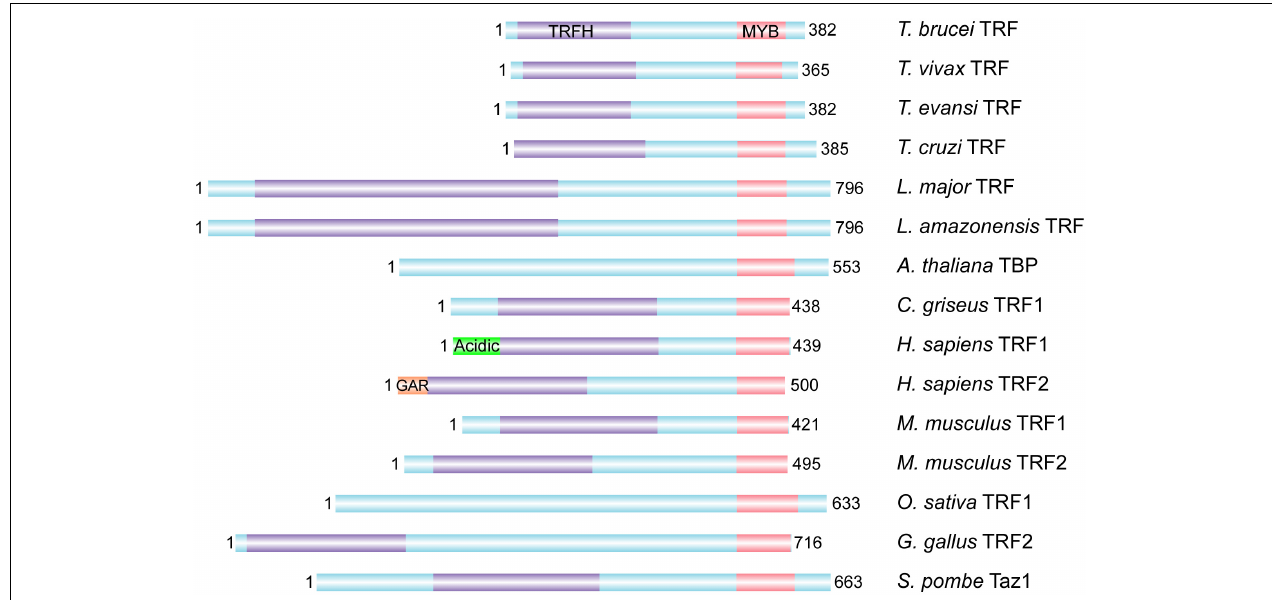
FIGURE 2 | TRF homologs from various organisms. The DNA binding Myb domain, the homodimerization TRFH domain, the N-terminal acidic domain of human TRF1 and basic GAR domain of human TRF2 are marked whenever identified. In addition, Leishmania amazonensis TRF has been identified and shown to associate with the telomere (da Silva et al., 2010). T. brucei , Trypanosoma brucei ; T. vivax , Trypanosoma vivax ; T. evansi , Trypanosoma evansi ; T. cruzi , Trypanosoma cruzi ; L. major , Leishmania major ; L. amazonensis , Leishmania amazonensis ; A. thaliana , Arabidopsis thaliana ; C. griseus , Cricetulus griseus ; H. sapiens , Homo sapiens ; M. musculus , Mus musculus ; O. sativa , Oryza sativa ; G. gallus , Gallus gallus ; S. pombe , Schizosaccharomyces pombe